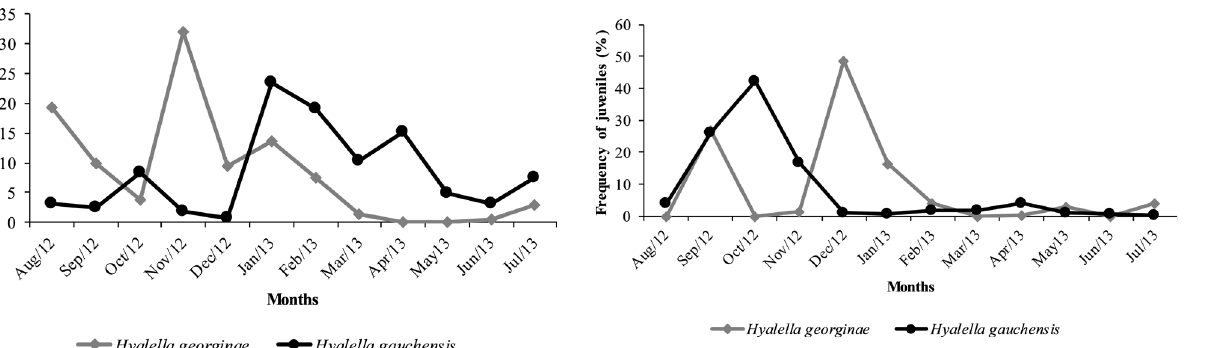
Figure 8. Relative frequency (%) of juveniles of Hyalella georginae and Hyalella gauchensis along year study, Palmeira das Missões, state of Rio Grande do Sul, Brazil.